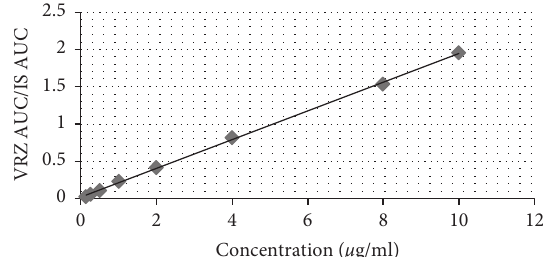
Figure 2: Linear relationship between area under the curve (AUC) of voriconazole/clonazepam peak ratio and plasma concentration of voriconazole over a range of 0.125–10 μ g/ml (VRZ, voriconazole; IS, internal